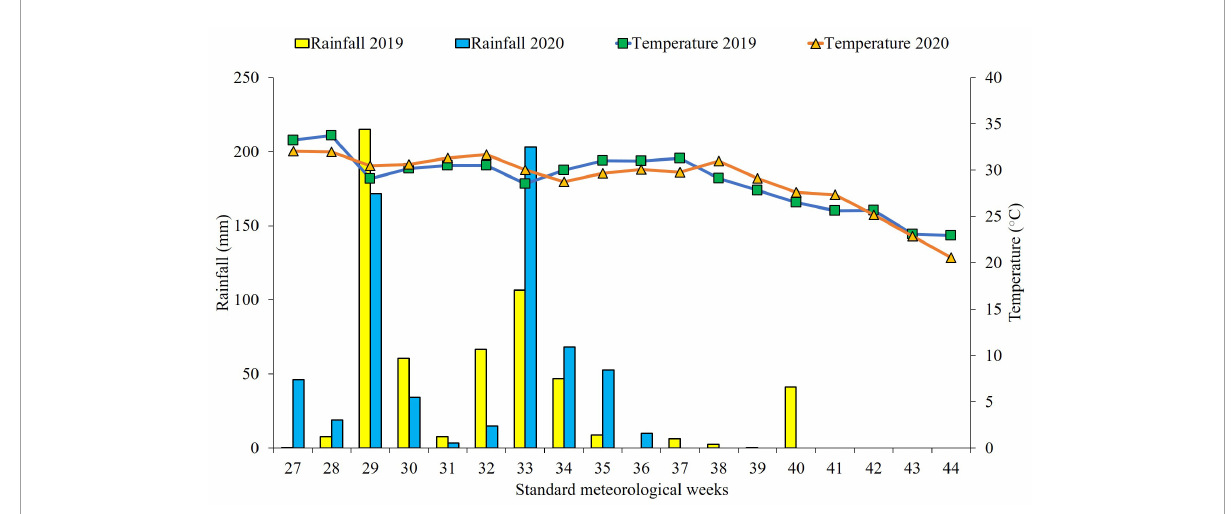
FIGURE1 Weekly rainfall and mean temperature during crop growing seasons (2019–2020). [Source: Agro-meteorological Observatory, Division of Agricultural Physics, ICAR-IARI, New Delhi].